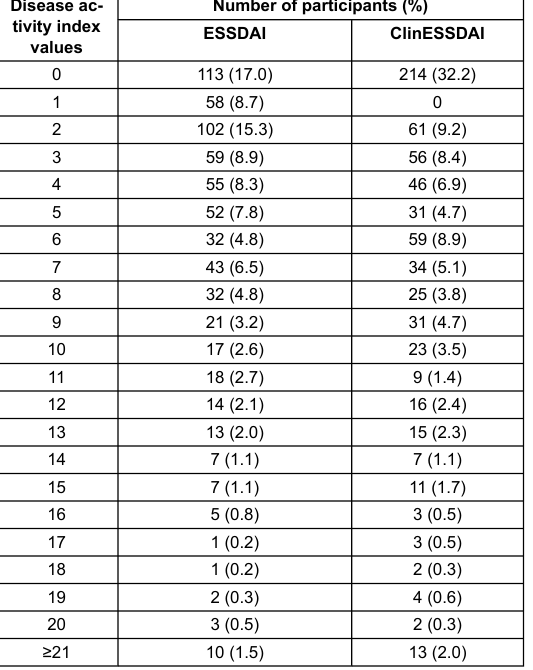
Table 2: Distribution of participants from the UKPSSR according to disease activity score, calculated with ESSDAI or ClinESSDAI, total n = 665.